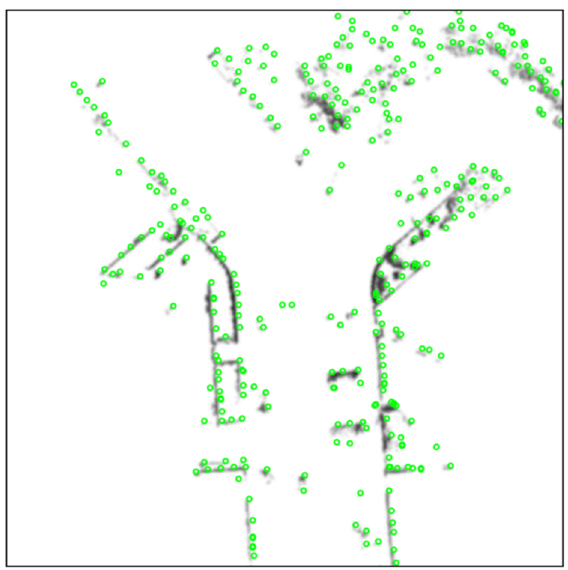
Figure 2. Keypoints detected by R2D2 net on KITTI dataset. The green circles are keypoints, and the background grayscale image is the BEV of LiDAR data.